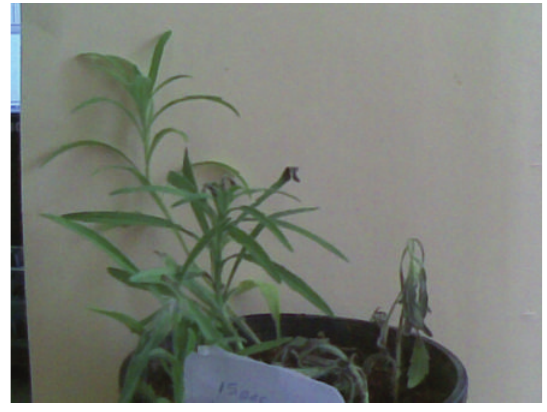
Figure 1: Selective application of microwave energy to plants in the same pot (left: una ff ected; right: 15 second microwave treatment).